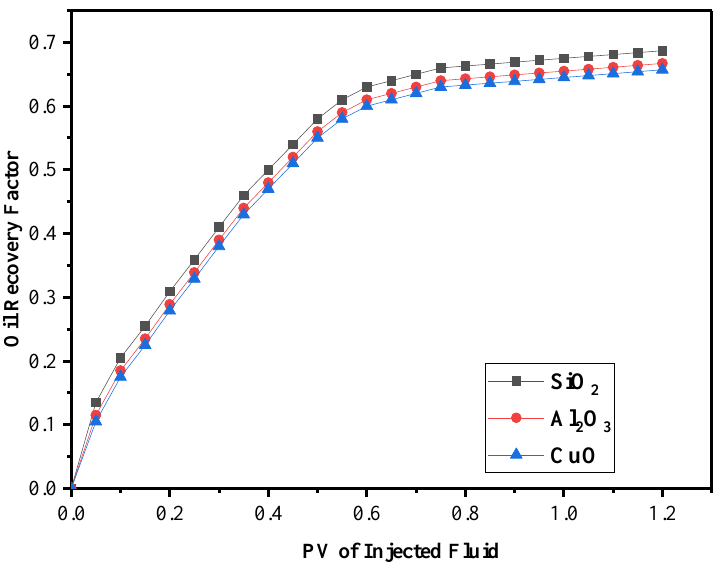
Figure 12. Comparison of nanoparticles SiO 3 , Al 2 O 3 , and CuO recovery coefficients. By using nanoparticles in the fluid, the specific heat capacity of the fluid decreased, and the heat transfer coefficient of the fluid was exceptionally high. Due to the ease and speed of heat transfer input temperature, in this case, rapid changes and increased process performance were possible. The recovery coefficient was determined for two different fluid input temperatures in Figure 13. The amount of oil produced from the reservoir increased dramatically when the fluid intake temperature rose. Furthermore, because of the nanoparticles’ strong thermal transfer characteristics, the heat was transferred to the oil inside the reservoir more quickly. As a result of the decreased viscosity and density of reservoir oil, the recovery factor was improved.